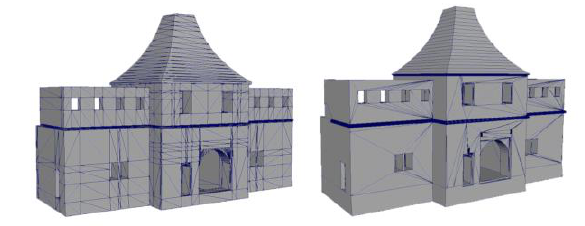
Figure 7: Decomposition of the simplified entrance of the castle (left into quads Maya , right into triangles SketchUp